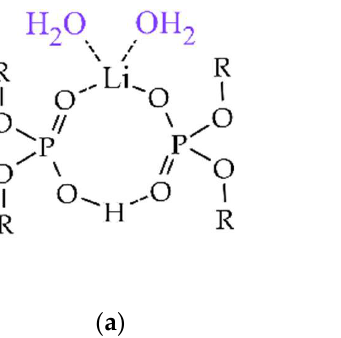
Figure 3. Hypothetical structures for Li extraction with D2EHPA (R = C 8 H 17 ), where the Li coordi- nation is saturated with ( a ) H 2 O molecules and ( b ) a citrate ion.